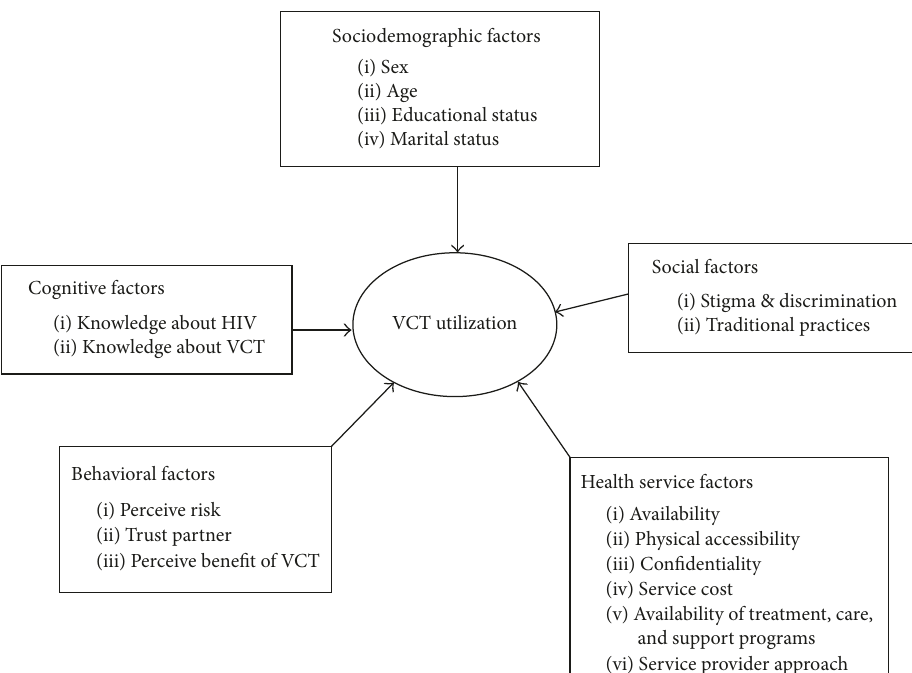
Figure 1: Conceptual framework for factors influencing VCT service utilization among secondary school teachers in Awi Zone, Amhara Region,